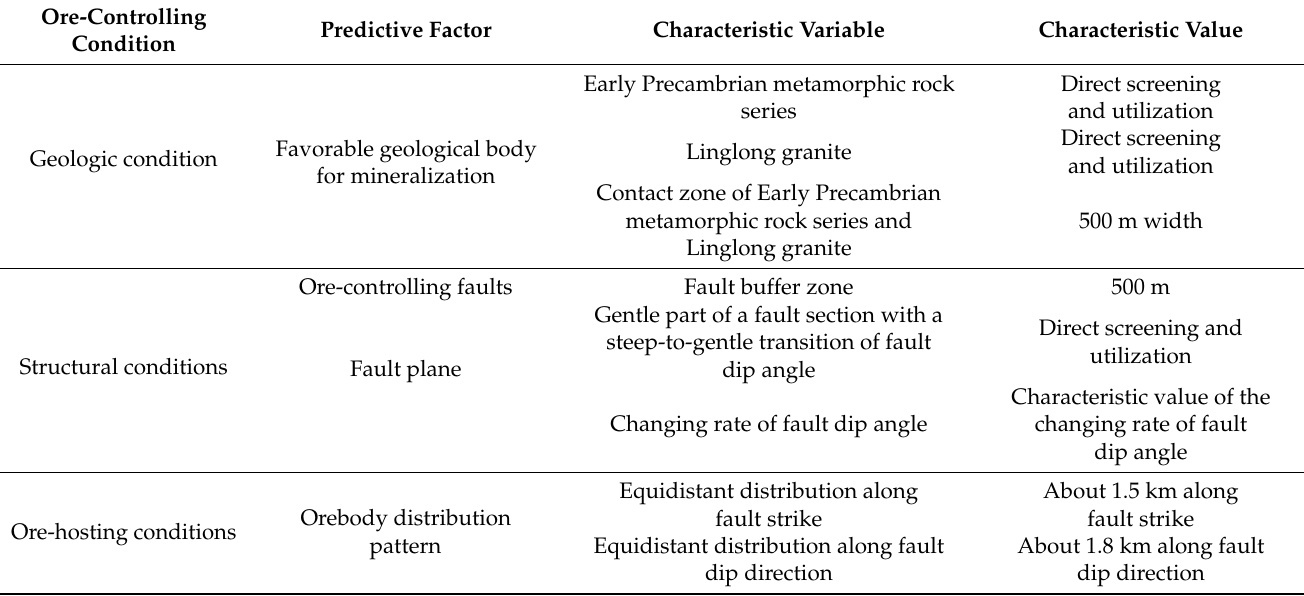
Table 1. Deep predictive model of the Jiaojia fault.